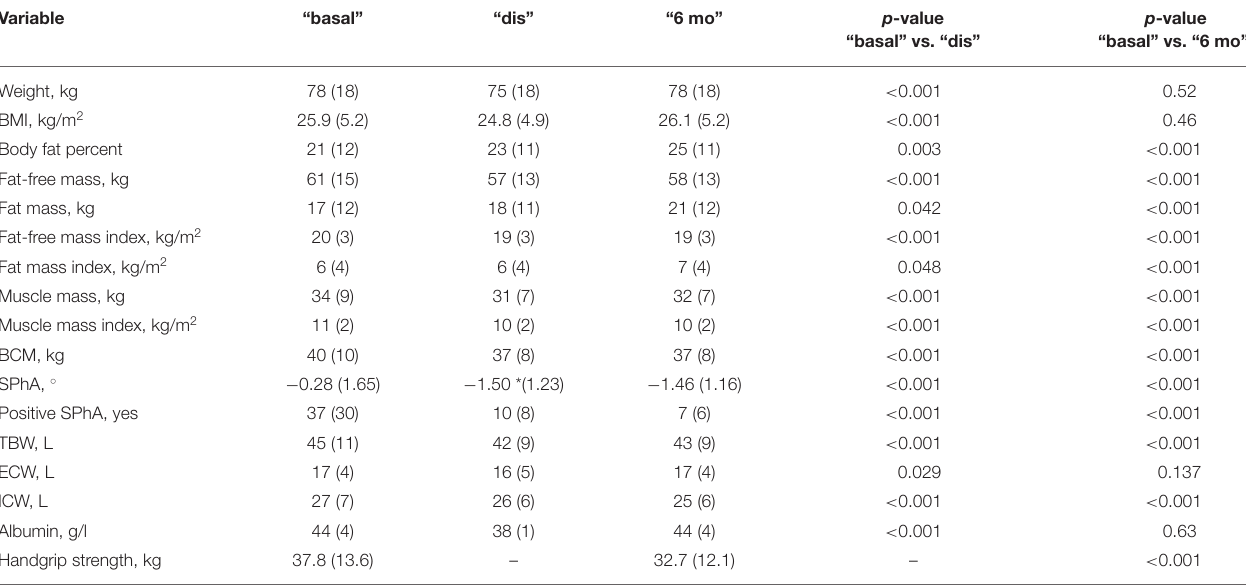
TABLE 2 | Comparison of nutrition-related variables during the early posttransplant